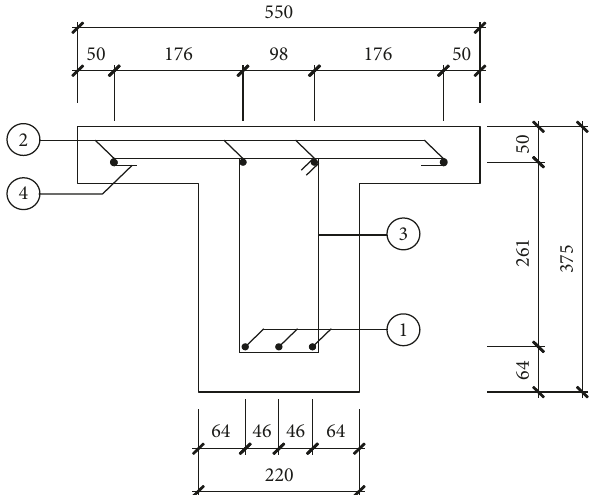
Figure 3: Reinforcement of model beam